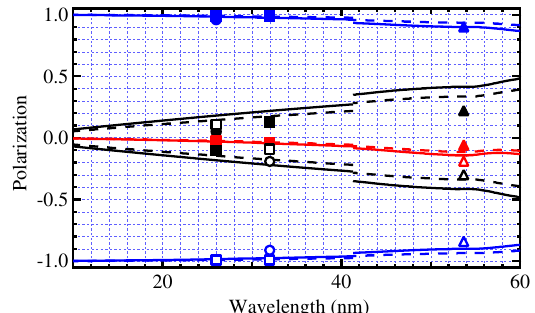
FIG. 14. Predicted impact of the LDM (dashed lines) and DiProI (continuous line) beam-line optics on the Stokes param- eters (red ¼ S 1 =S 0 , black ¼ S 2 =S 0 , blue ¼ S 3 ) for a circular polarized light produced at the undulator. Predictions are shown together with measured Stokes parameters at the experimental stations (circular-right filled symbols and circular-left empty symbols) reported in Tables V, VI, and VII and obtained with the LDM setup (triangles), VUVoptical polarimeter (circles), and e-TOF polarimeter (squares). See Fig. 3 for the step at ≈ 41 . 3